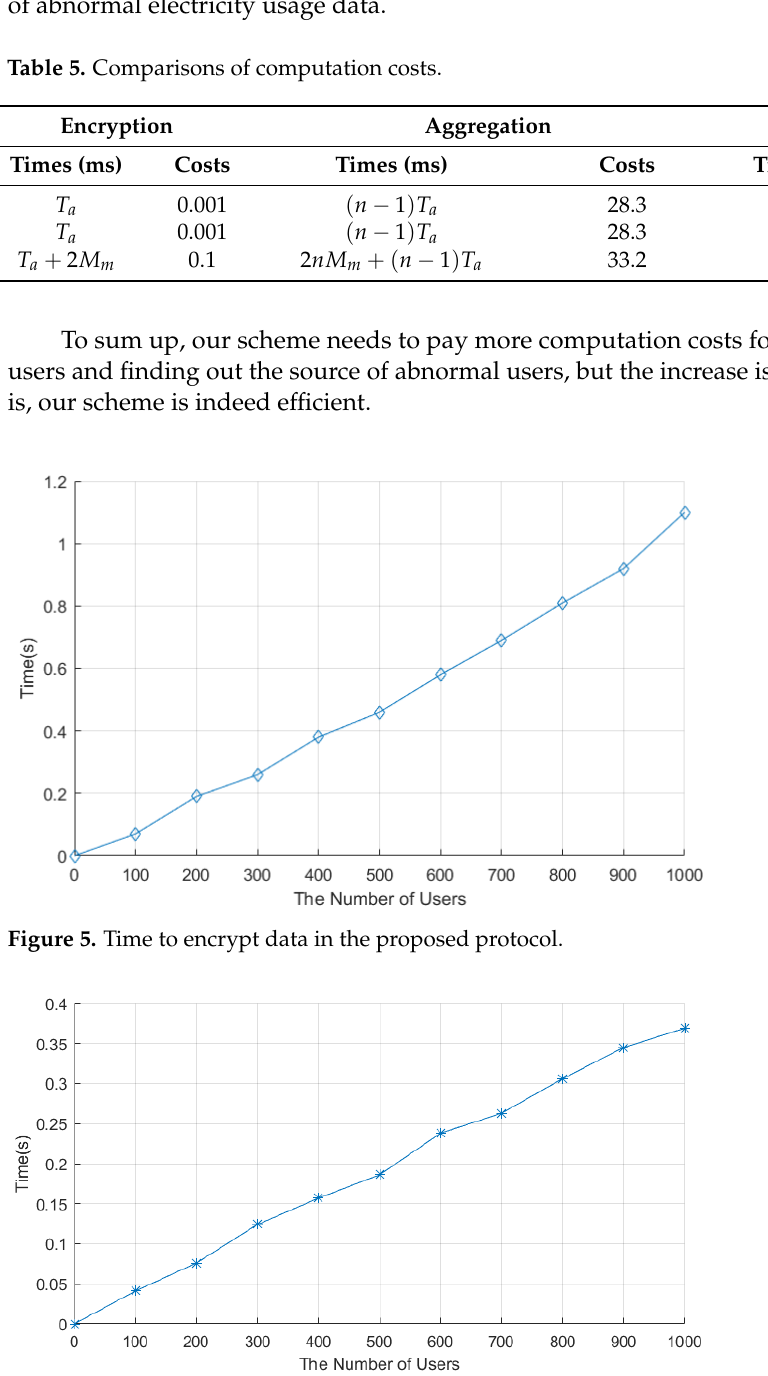
Figure 6. Time to aggregate data in the proposed